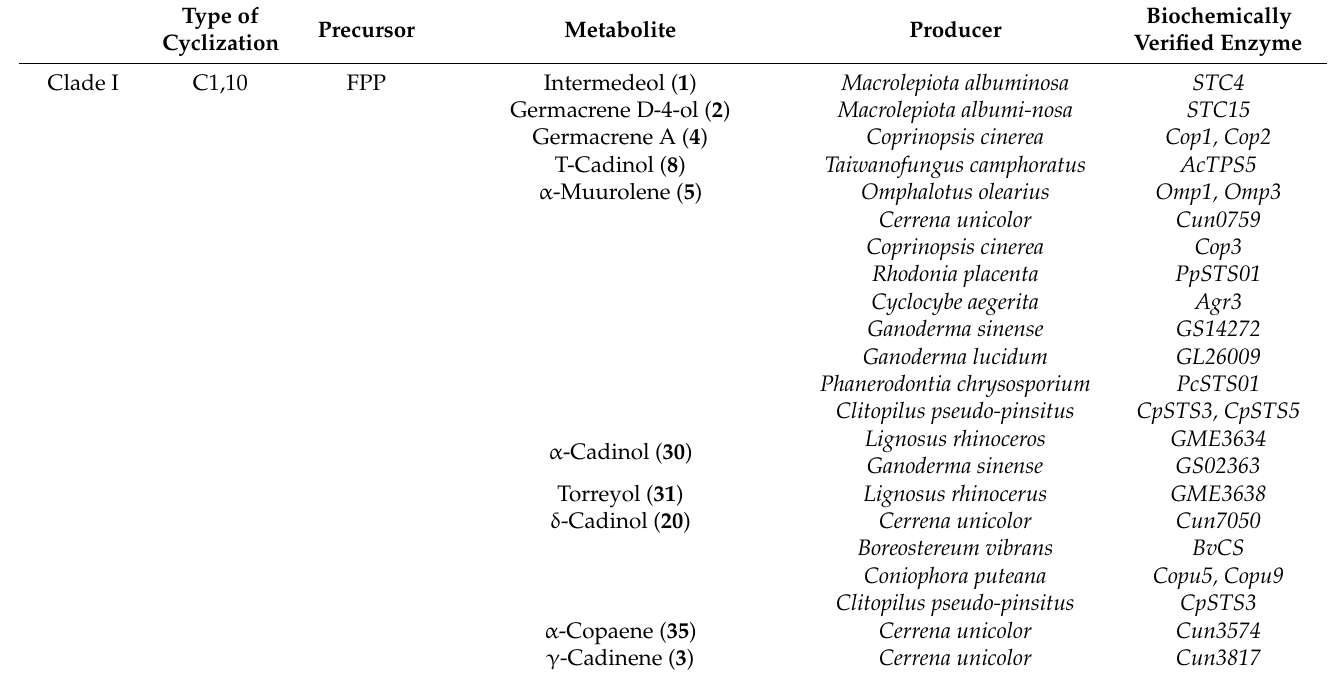
Table 1. Classification of STSs from